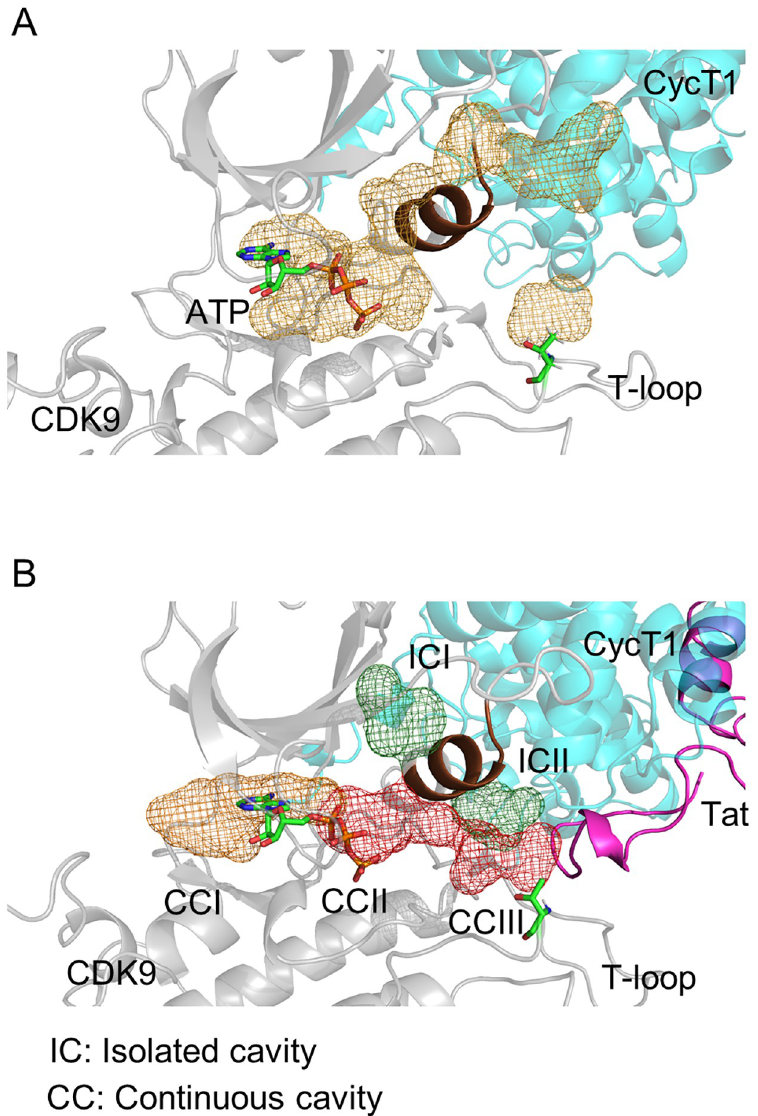
Fig 2. Details of the CDK9 hidden cavity induced by Tat binding. (A) Cavities on CDK9 formed with CycT1. CDK9, CycT1, and Tat are shown as gray, cyan, and pink ribbons, respectively. ATP and phosphate atoms are shown as a stick. PITALRE is shown as a brown cartoon. Cavities are shown with a mesh (orange). (B) The cavities within CDK9 induced by Tat binding, ICI and II, are shown as a green mesh. CCI–III are shown as orange and red meshes.